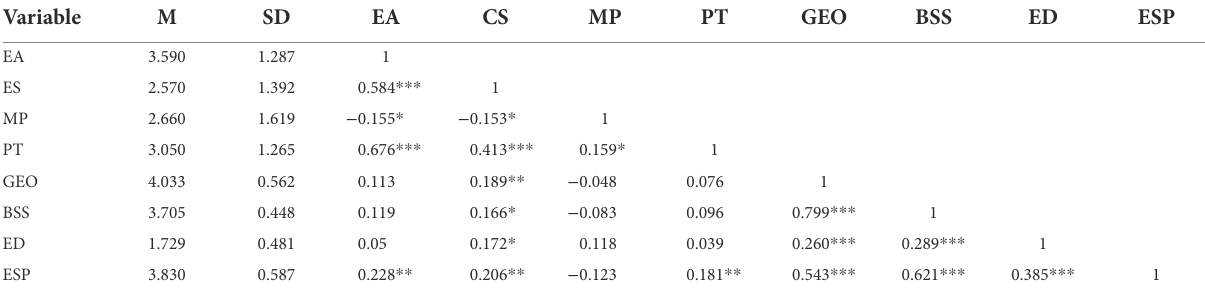
TABLE 4 Descriptive statistics and correlation analysis of variables.